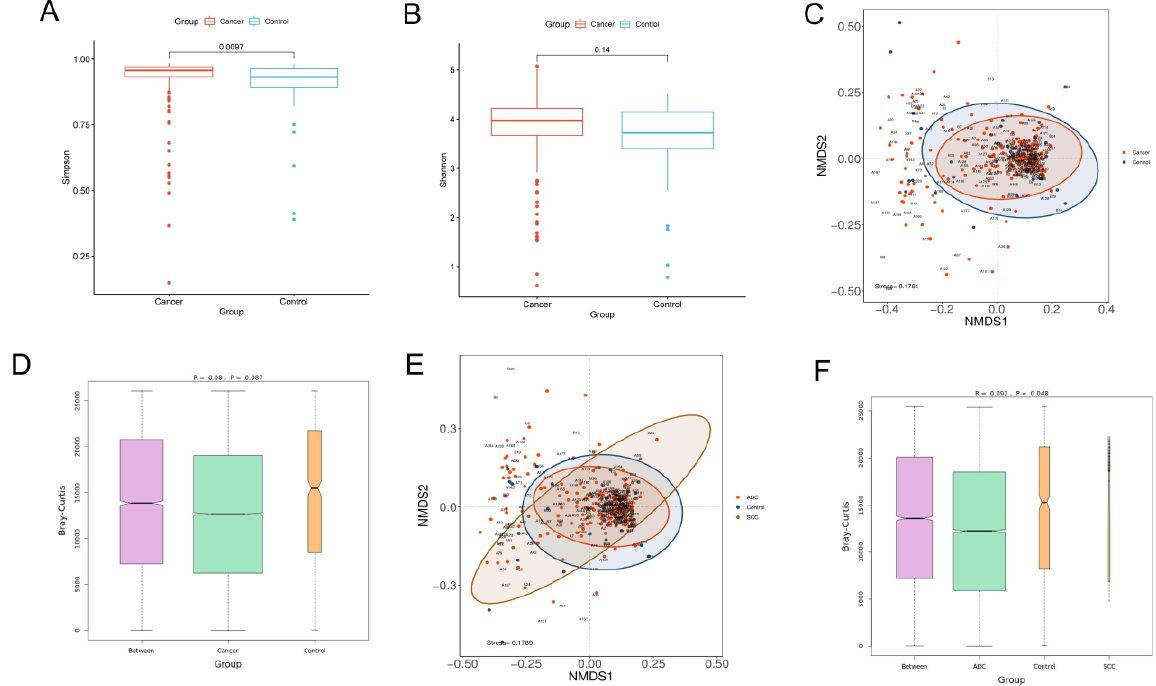
Figure 1. Diversity analysis for microbiota in BALF. Alpha diversity analysis between lung cancer and benign pulmonary nodules based on the ( A ) Simpson index (Wilcoxon rank − sum test, p < 0.05) and ( B ) Shannon index (Wilcoxon rank − sum test, p > 0.05); beta diversity analysis via NMDS based on the Bray − Curtis distance ( C ). ANOSIM analysis was used as a statistical test for beta diversity ( D ). The R value obtained in ANOSIM analysis was between − 1 and 1. A value closer to 1 indicates that the difference between groups is greater than that within groups. When the p value is less than 0.05, the reliability of the test is high. Longitudinal seating represents the Bray − Curtis distance. Comparison of beta diversity analysis among adenocarcinoma, squamous carcinoma and benign lesions visualized in the NMDS plot ( E ). ANOSIM analysis was used as a statistical test for beta diversity. ANOSIM analysis box plot ( F ).